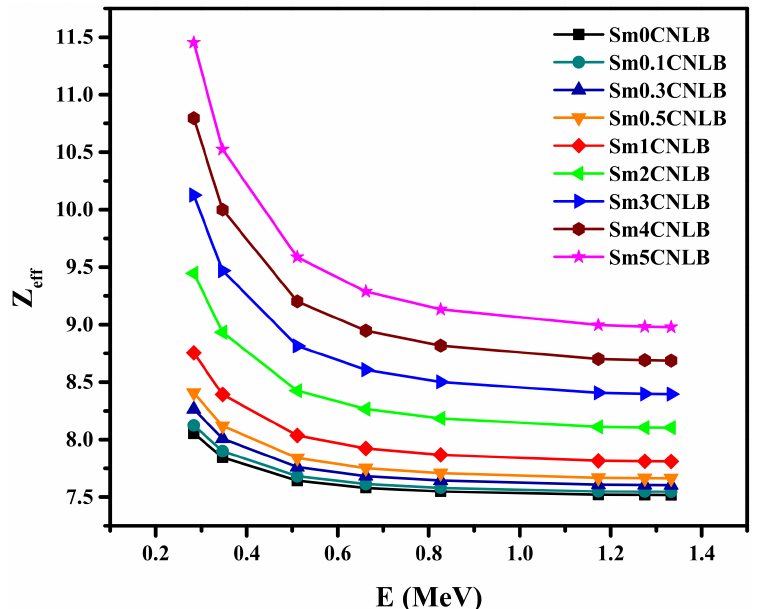
Figure 8. The effective atomic number values of the presented Sm–CNLB glasses.